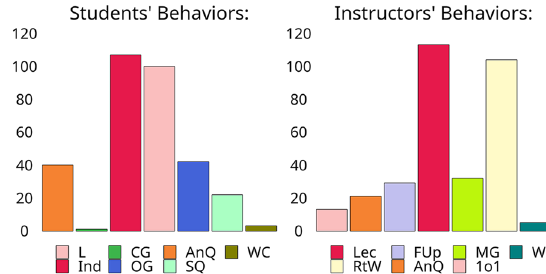
Fig. 5 Histograms of the COPUS behaviors over the Med period